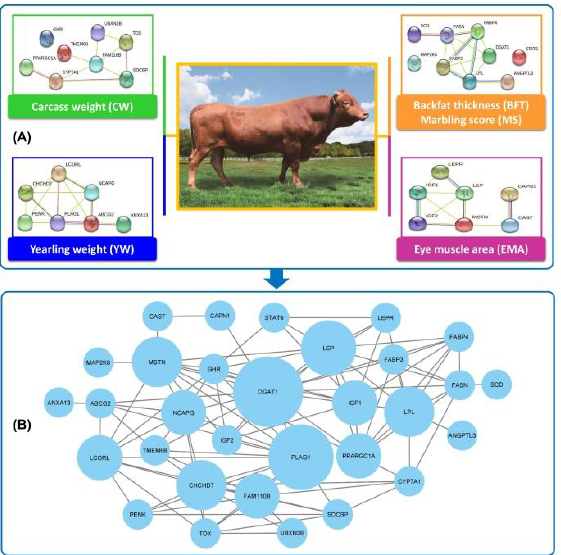
Figure 2. Protein–protein interaction (PPI) network analysis using STRING database. ( A ) PPI network analysis for genes connected to each trait in Hanwoo cattle. ( B ) The most significant hub genes in the PPI network are considered according to FDR < 0.05 and higher-degree connectivity value.